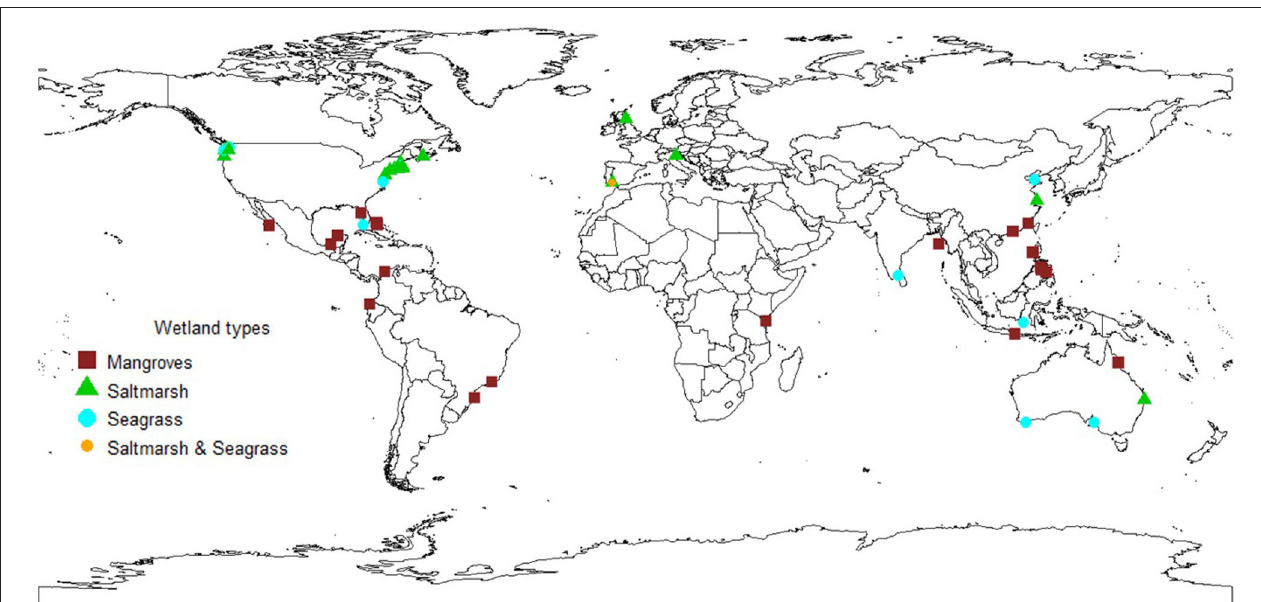
FIGURE 1 | Distribution of coastal wetlands restoration sites from studies reviewed.